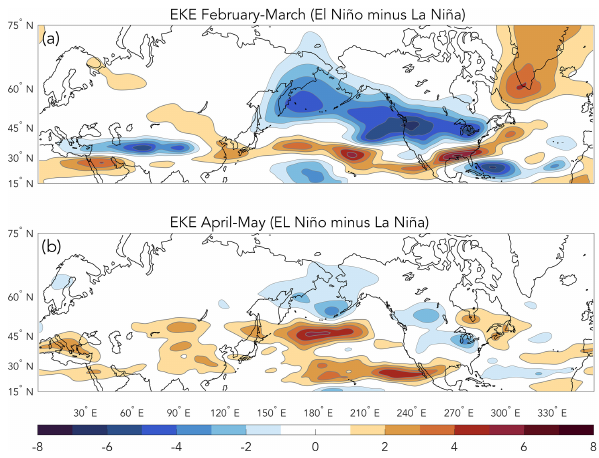
Figure 7. Anomaly composites of 200hPa pressure level eddy ki- netic energy (2 to 10d filtered) for (a) February–March (El Niño minus La Niña) and (b) April–May (El Niño minus La Niña). Units are square meters per square second (m 2 s − 2